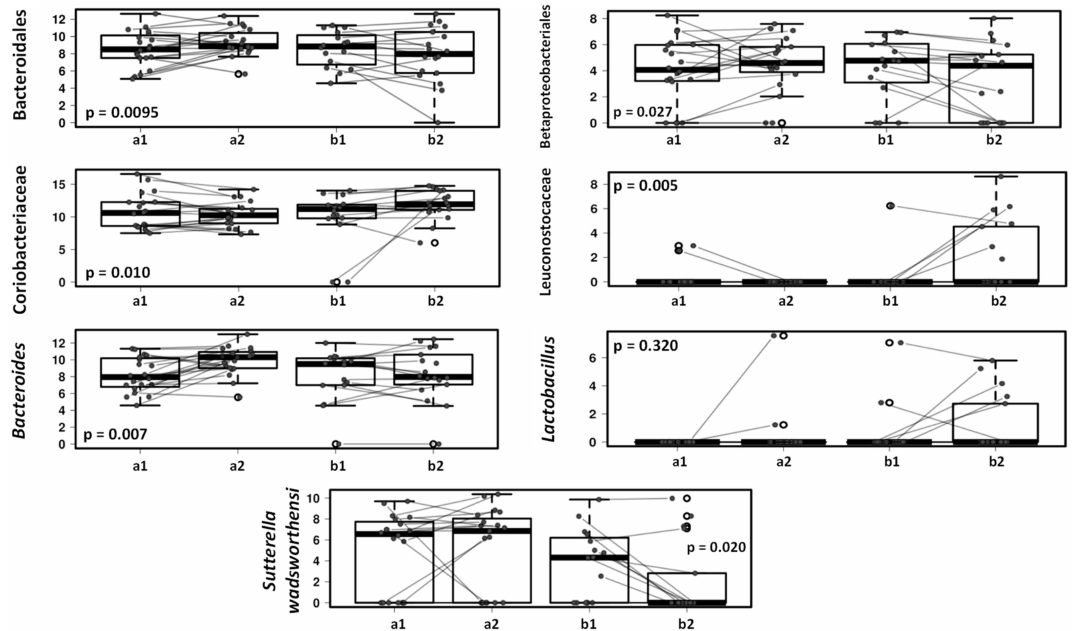
Figure 5. Mixed effect regression models (multilevel models) comparing fecal microbiota in dogs receiving placebo (a) vs. dogs receiving lactic acid bacteria preparation (b), before (1) and after 4-weeks intervention